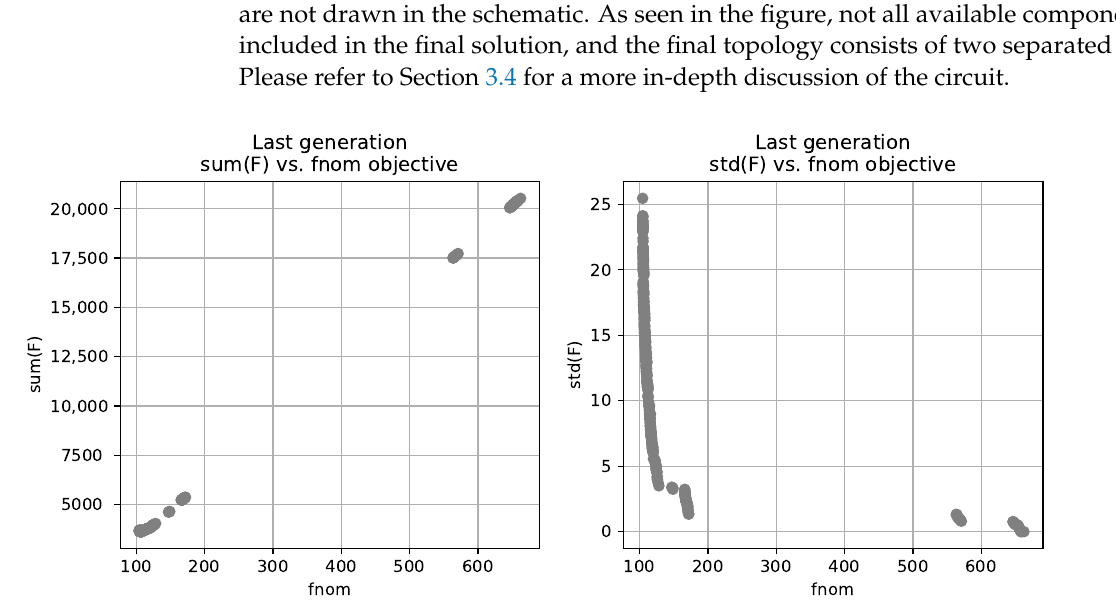
Figure 9. The Pareto front of the last generation of the evolution of the failure-resilient natural logarithm circuit. Shown are the tree objectives f nom , F Σ , and σ F .